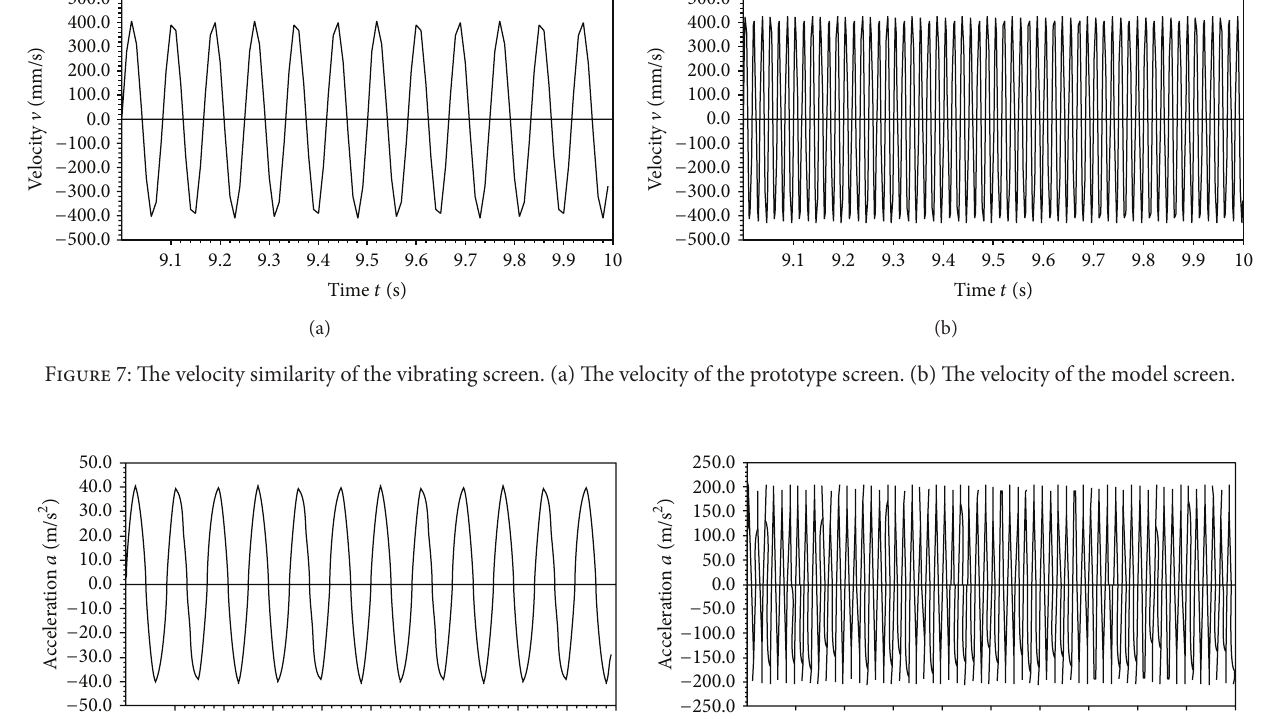
Figure 8: The acceleration similarity of the vibrating screen. (a) The acceleration of the prototype screen. (b) The acceleration of the model